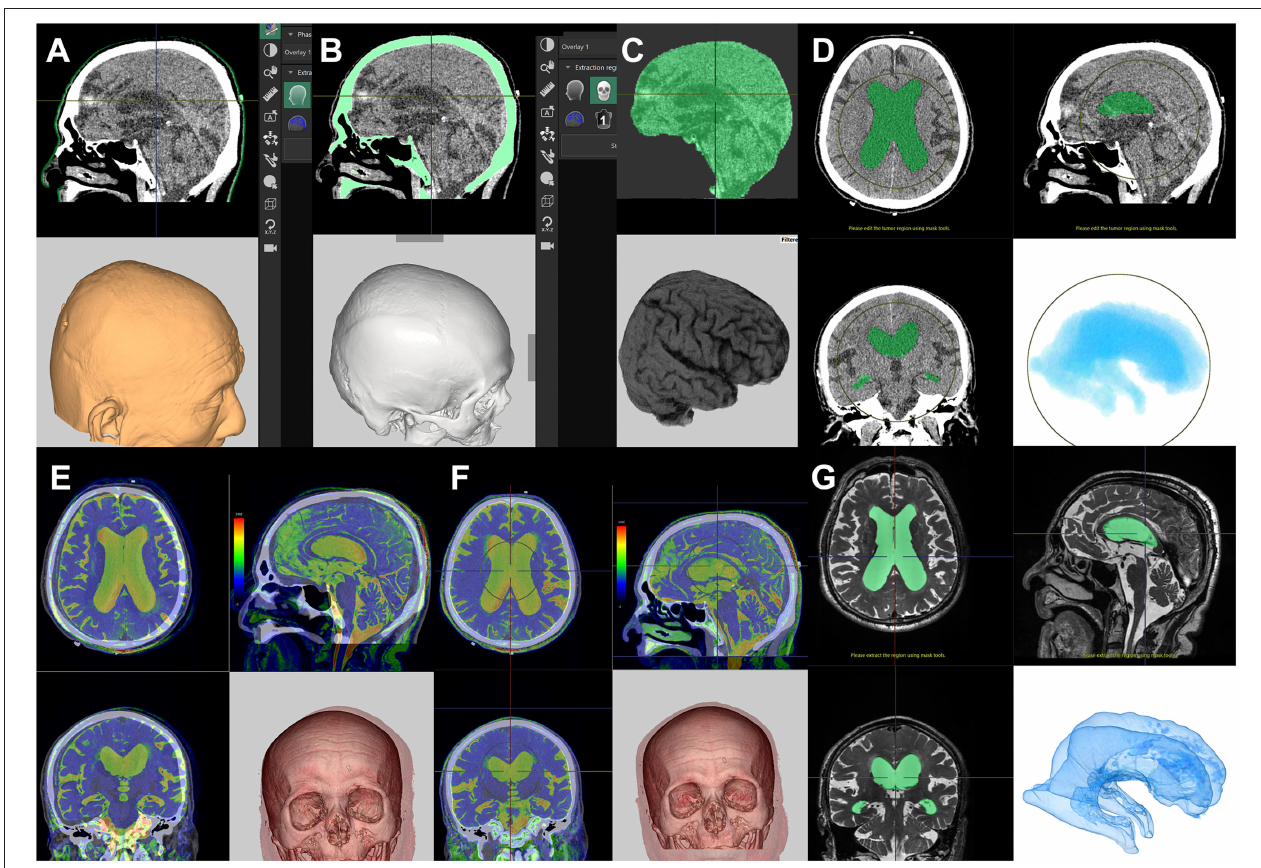
FIGURE 2 | Preparation for computational virtual simulation of ventricular puncture. Screenshots of the Craniotomy/Tensor Analysis application on the SYNAPSE 3D workstation. Clicking the buttons causes the following three imaging components to be extracted automatically from the plain head CT scan: scalp (A) , skull (B) , and brain (C) . After the automated extraction, the lateral ventricle images were manually extracted from the brain (D) . If the patient has had a 3D-MRI for iNPH diagnosis, the T2-weighted 3D MRI is superimposed on the CT scan (E) . The CT and superimposed MRI images are automatically aligned with a single click (F) . The lateral ventricle images from T2-weighted 3D-MRI images (G) are easier and clearer to read than CT images (D)